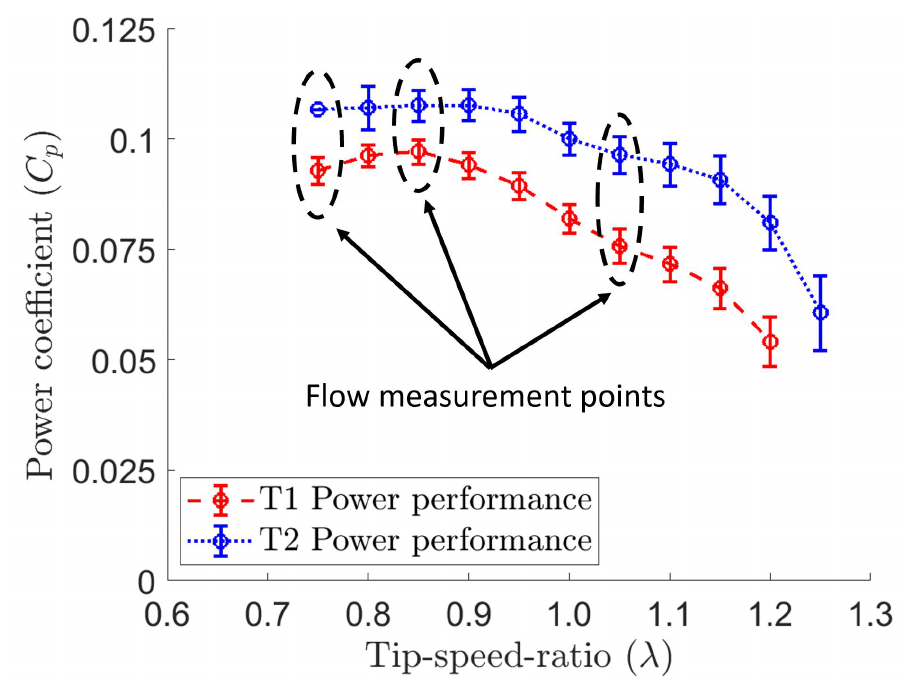
Figure 6. The power curve of each turbine with the flow measurement points highlighted. In the power measurement experiment, turbine T2 stalled at λ = 0.75 [25]. This figure displays a linear extrapolation of T2 C P at λ =